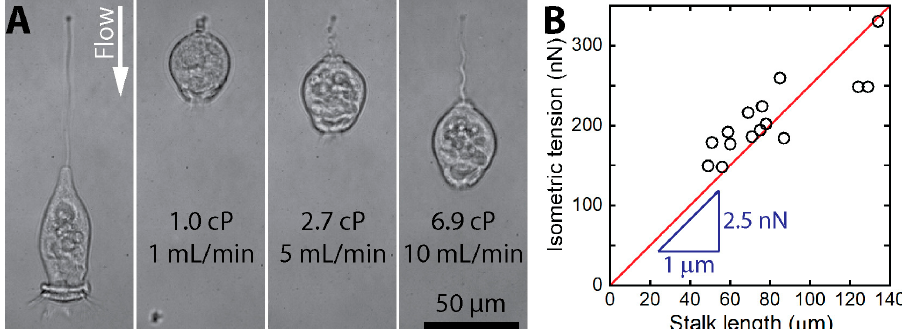
Figure 11. Isometric force measurements of live V. convallaria (reproduced from [16]). ( A ) V. convallaria stalled by viscous drag in a microchannel. The leftmost picture shows extended state, and the subsequent show contracted states under different flow conditions; ( B ) measured isometric tensions increased from 150 to 330 nN with a linear dependence on the stalk length, which suggests that the 1 μ m of the spasmoneme can generate a tension of up to ~2.5 nN.